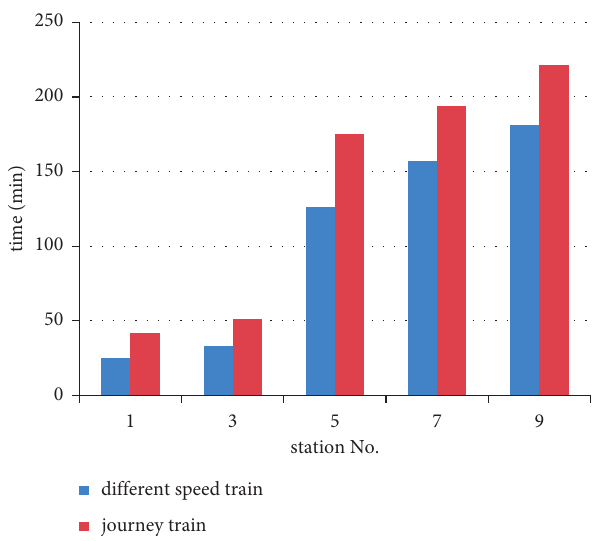
Figure 4: Comparative analysis of the passenger waiting